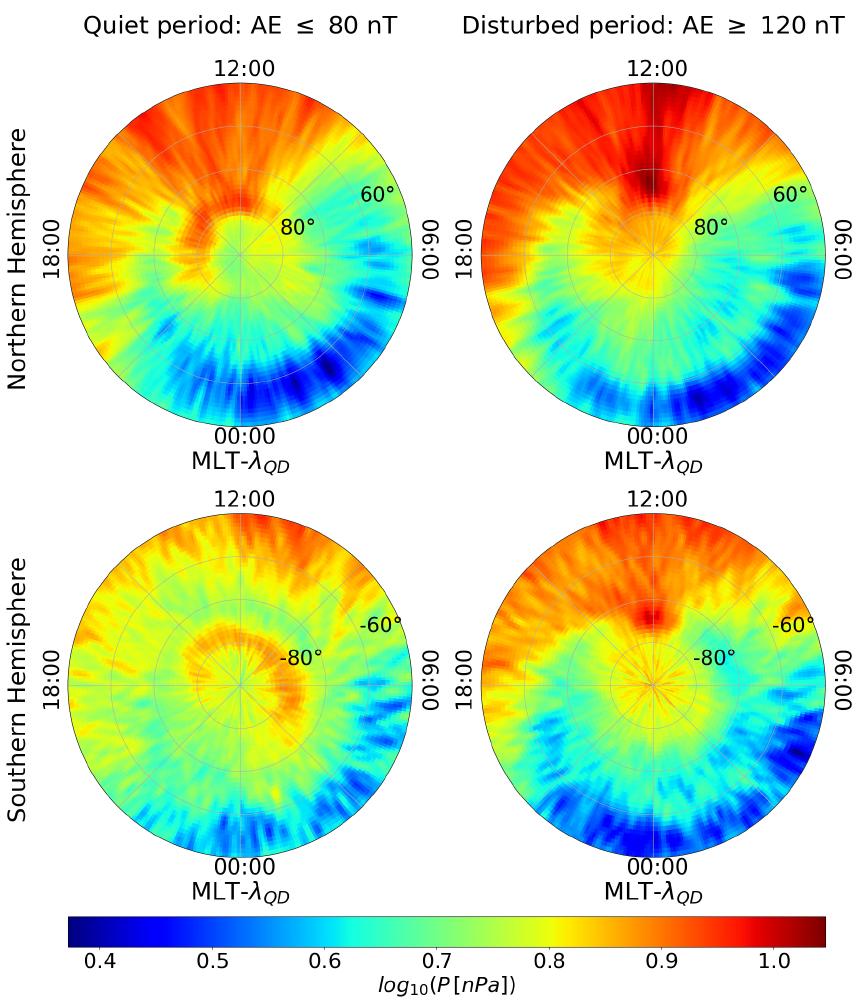
Figure 3. Polar view of the average spatial distribution of plasma pressure for quiet ( left column) and disturbed ( right column) geomagnetic activity conditions, for the Northern and Southern hemi- spheres, in QD-latitude ( λ QD > 50 ◦ and λ QD < − 50 ◦ for the Northern and Southern hemisphere, respectively) and MLT reference system. Maps are obtained using data recorded by Swarm A from 1 April 2014 to 28 February 2018. The concentric dashed circles represent contours of magnetic latitude separated by 10 ◦